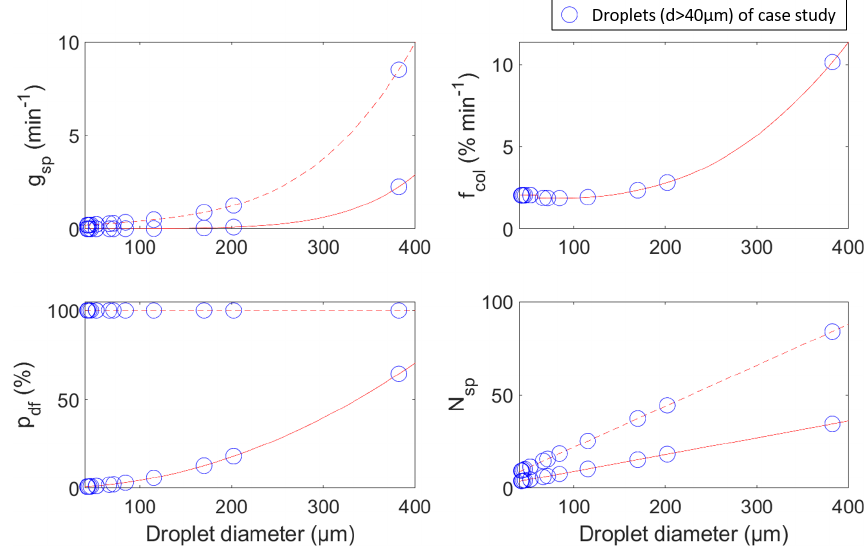
Figure 8. The plots show the different parameters of the splinter generation rate g sp (d n ) (Eq. 1) for the first assumptions (Eqs. 3–5; solid lines) and for the tuned version of N sp in turbulent conditions that can explain the observations (Eqs. 9 and 10; dashed